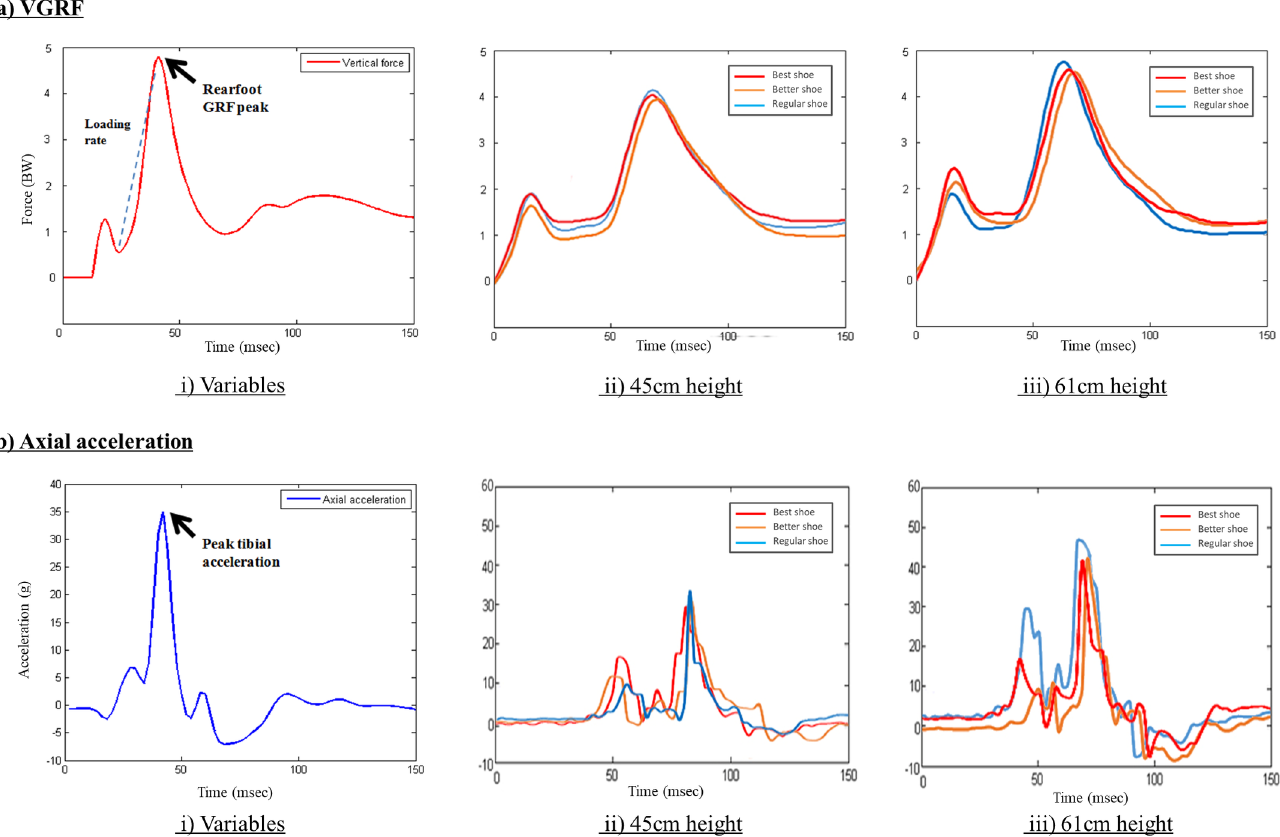
Fig 1. Representative vertical ground reaction force (VGRF) and axial acceleration versus time profiles of a drop landing in different shoe and height